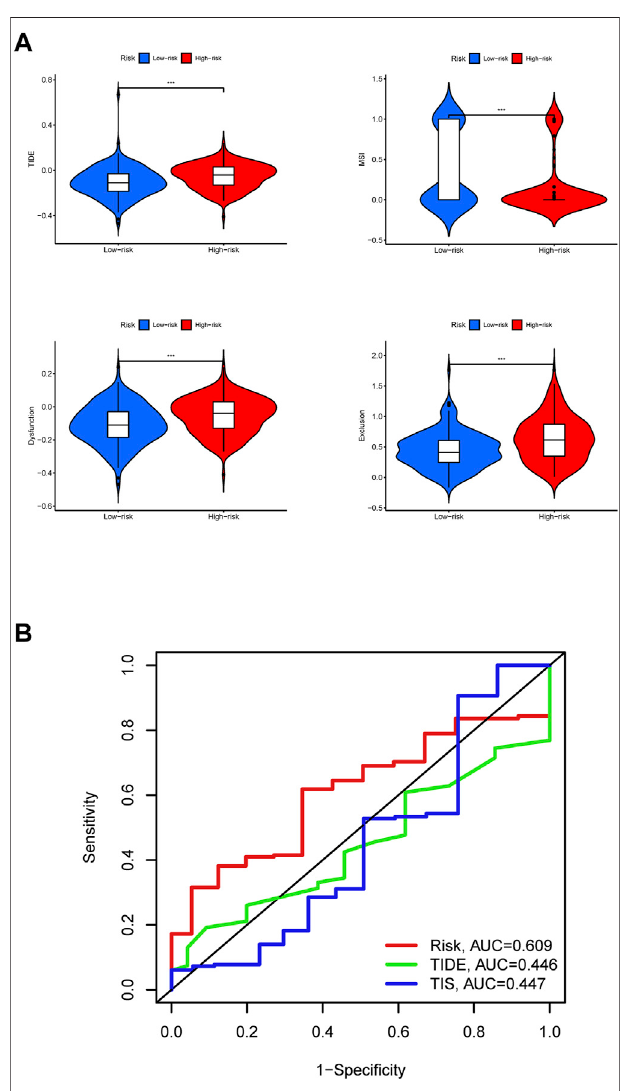
FIGURE 11 | Ef fi cacy prediction of immunotherapy and model comparison. (A) Violinplots.Thecomparisonofimmunotherapybiomarkersin highandlowriskcategories.*, p < 0.05.**, p < 0.01.***, p < 0.001. (B) 5-years ROC curves.